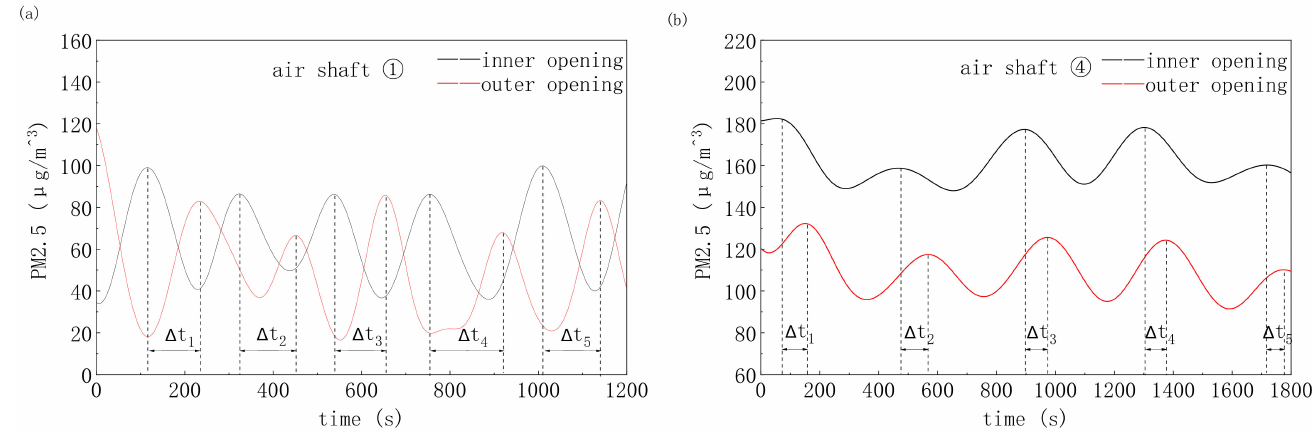
Figure 12. Filtering of PM2.5 concentration at the inner opening and outer opening of ( a ) air shaft 1 (cid:13) and ( b ) air shaft 4 (cid:13)